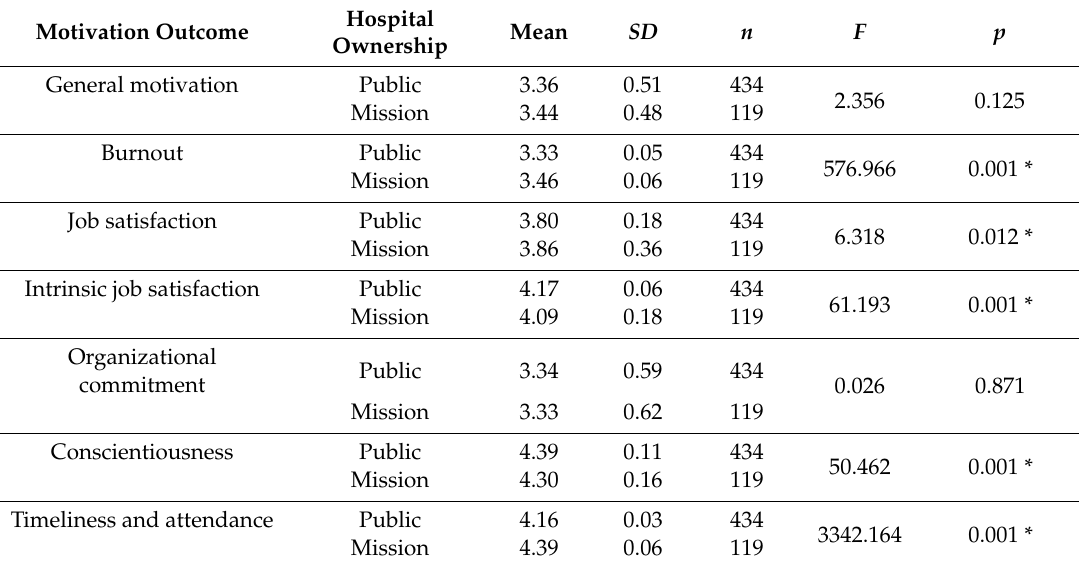
Table 5. Motivation outcomes ANOVA by hospital